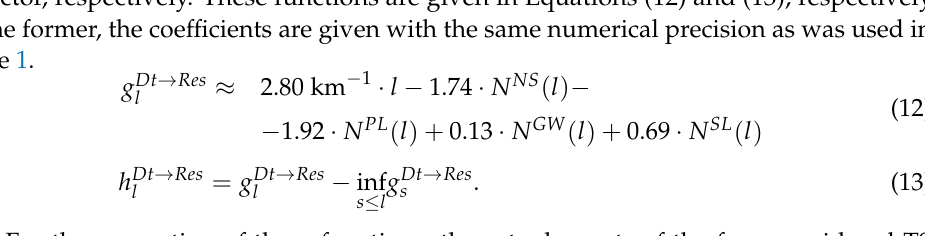
Table 1. The empirical traffic sign (TS) rates along a random route for the homogeneous marked Poisson processes describing (downtown) Dt and residential (Res) urban road environments.